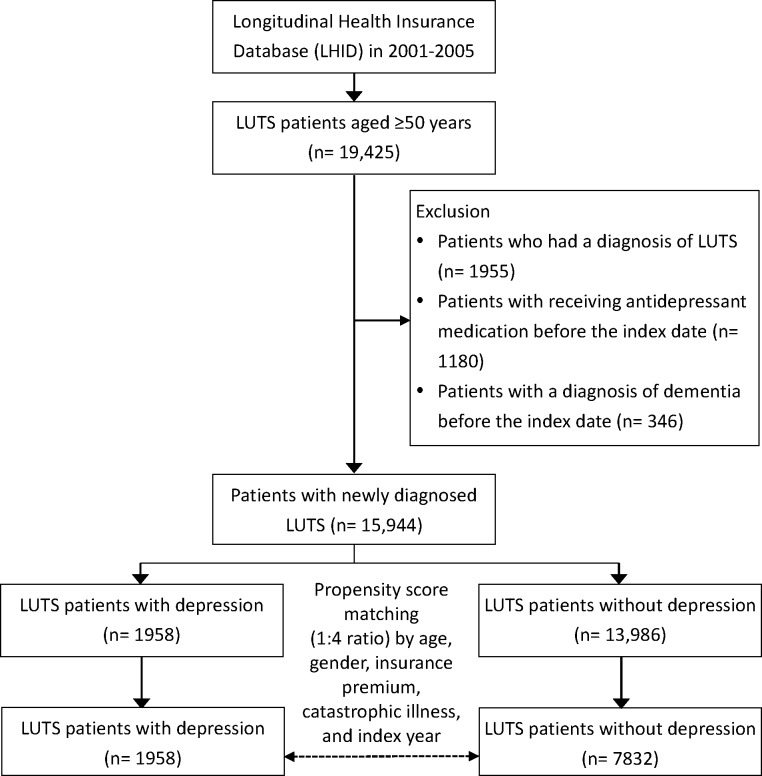
Schematic illustration of the study population and patient-selection criteria.